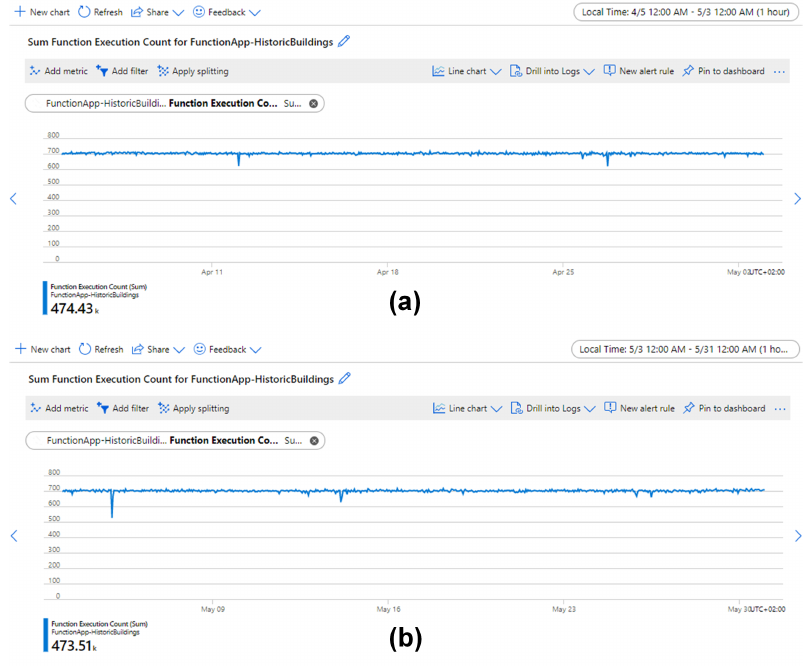
Figure 13. Hourly aggregated metrics for executed function count between 5 April and 31 May. The total executed function count was ∼ 947,940. Among them, ( a ) ∼ 474,430 function counts were executed between 5 April and 3 May and ( b ) ∼ 473,510 function counts were executed between 3 May and 31 May.